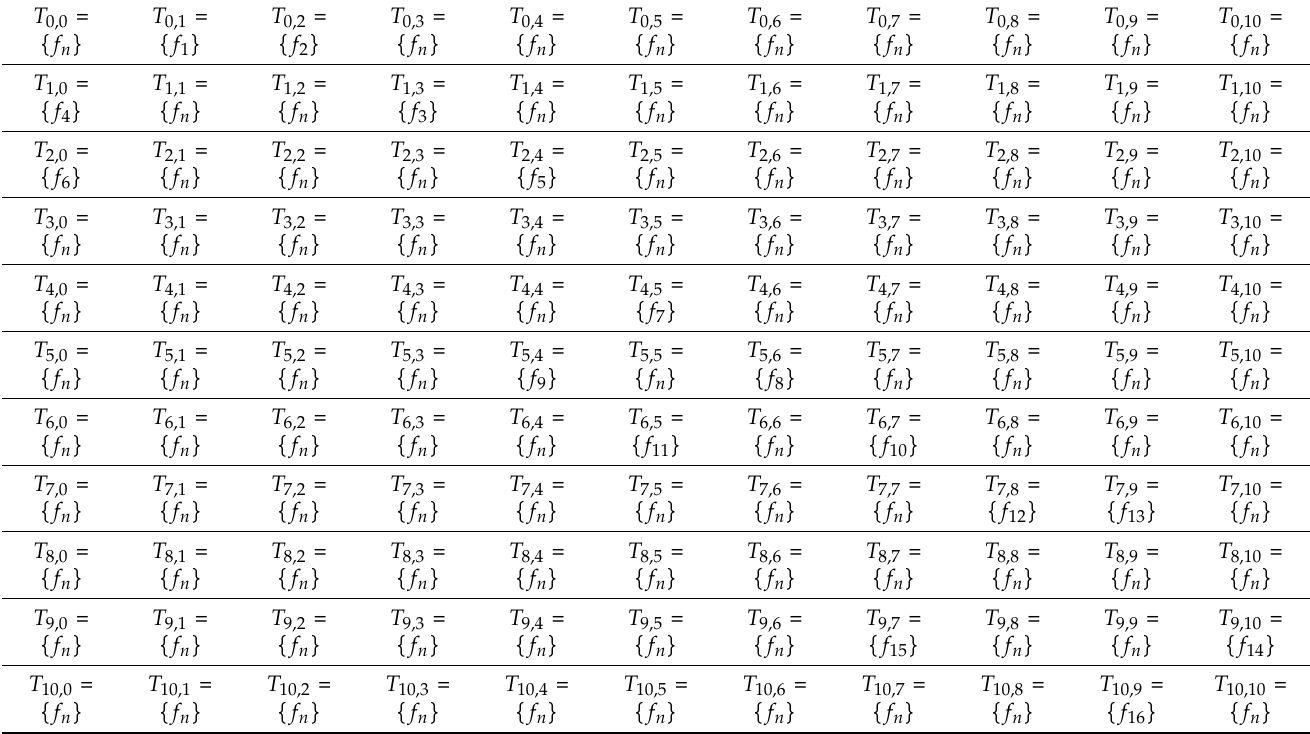
Table A3. Elements of the T set for scenario